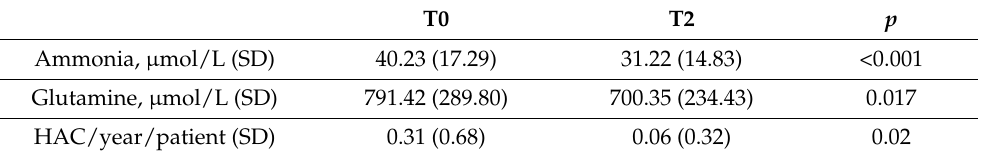
Table 4. Ammonia, glutamine and hyperammonemic crisis.